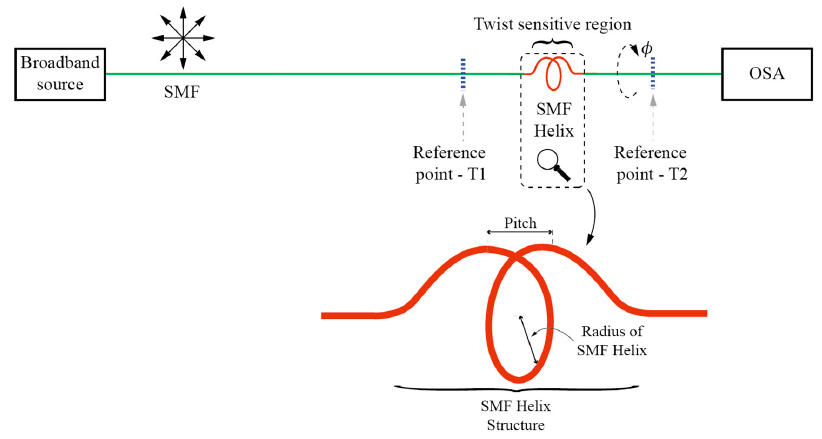
Figure 6. Modal MZI twist sensor experimental setup and illustration of the fabricated SMF